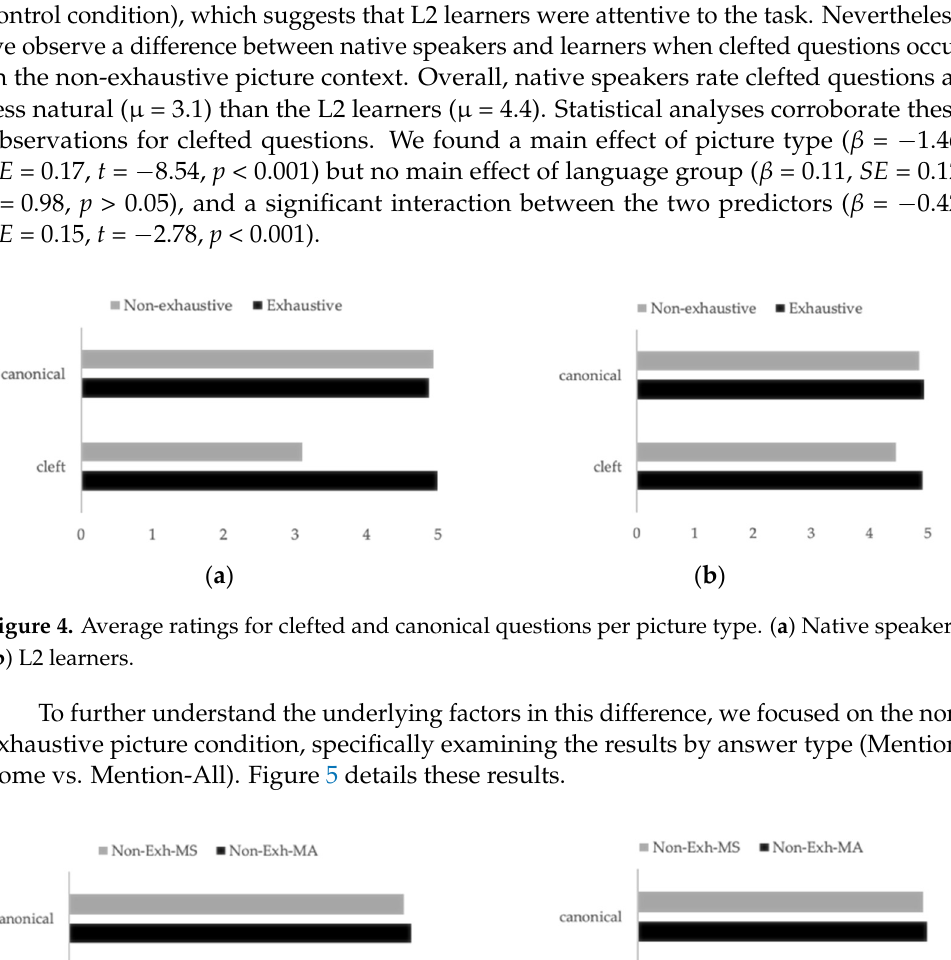
Figure 6. Average ratings for clefted questions in the non-exhaustive picture condition, per answer type and proficiency. The statistical analysis once again supports our descriptive results. We found no main effect of both individual predictor answer types ( β = 1.23, SE = 0.255, t = 4.94, p > 0.05) and proficiency ( β = 0.03, SE = 0.003, t = 8.28, p > 0.05), but a significant interaction between these two predictors ( β = − 0.10, SE = 0.005, t = − 18.58, p < 0.001). 5. Discussion Our experiments were motivated by the observation that the French interrogative system poses challenges for L2 acquisition given the wider array of structural possibilities it allows, including options that are ungrammatical in L1 English. Thus, the possibility of positive L1 transfer is limited. One such structure is a clefted question—a structure at- tested but less commonly studied in the French literature. Our paper focused on the L2